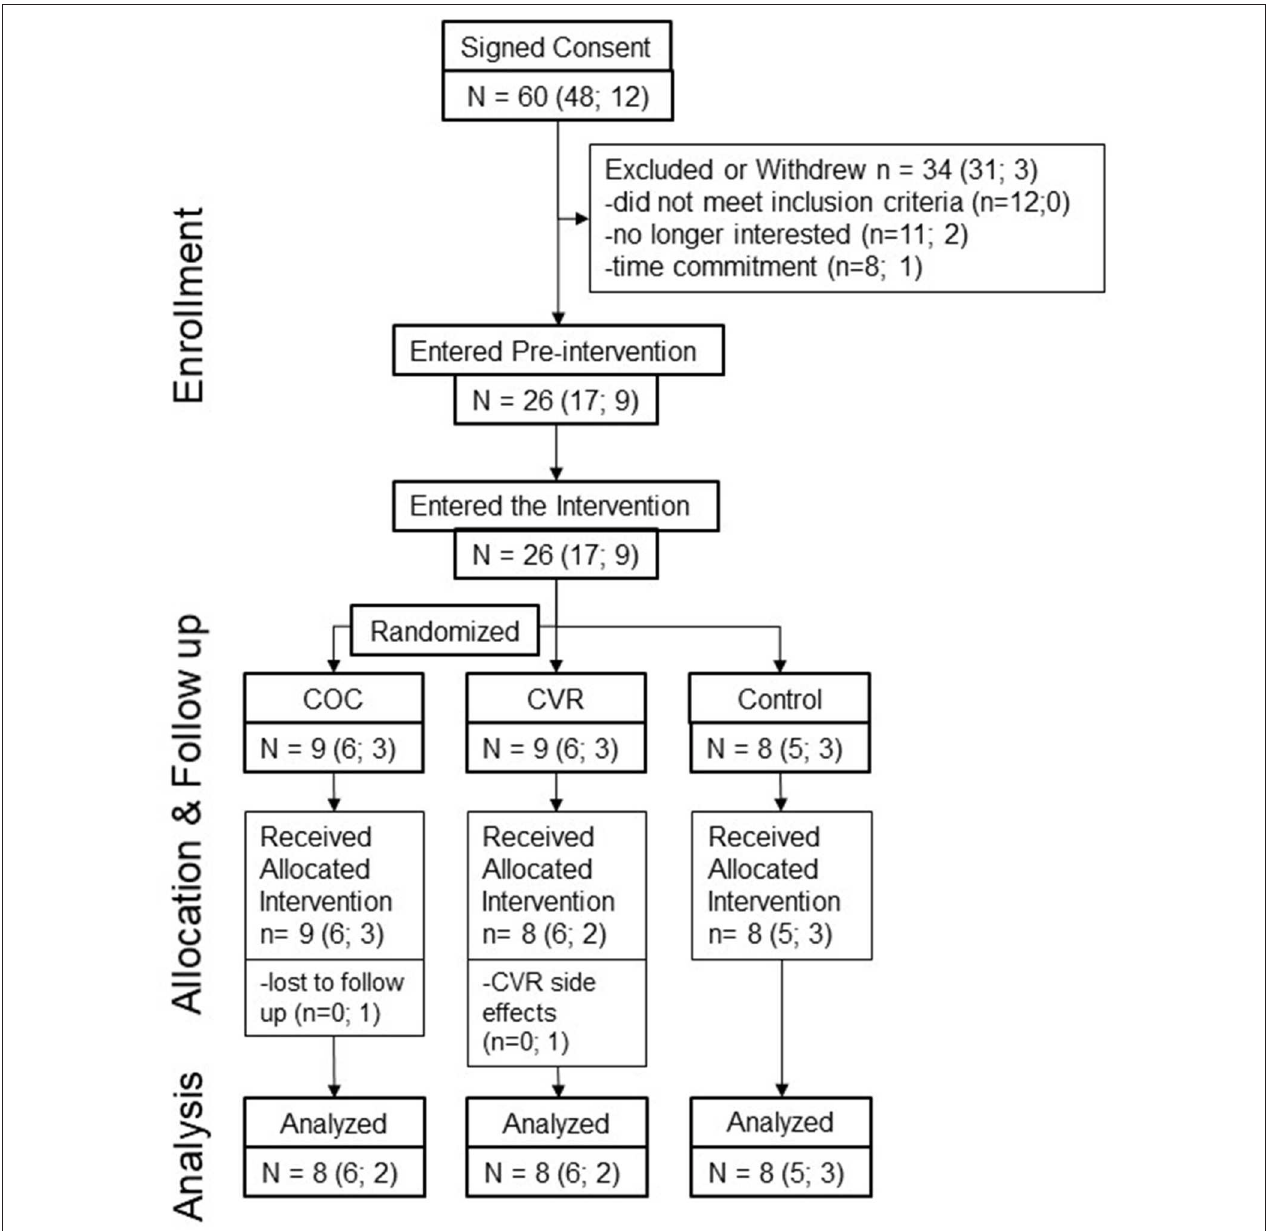
FIGURE 2 | Progression of study participants through the pilot study. Total study N is provided as well as n per study site in brackets (PSU; Purdue). COC, combined oral contraception; CVR, contraceptive vaginal ring.